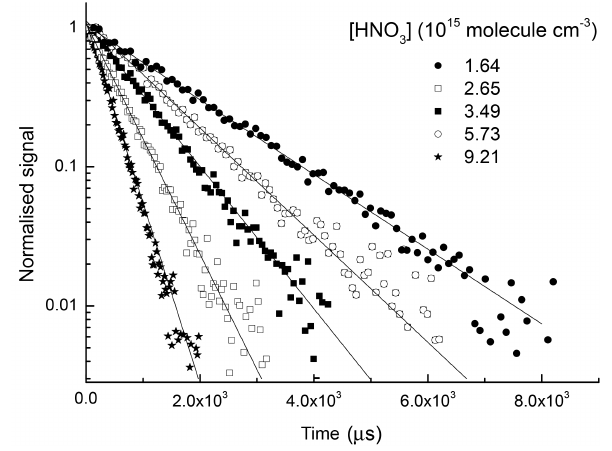
Figure 6. Corrected pseudo-first-order rate coefficients, k cor , plot- ted as a function of the HNO 3 concentration. The data were ob- tained at 242K and at three different